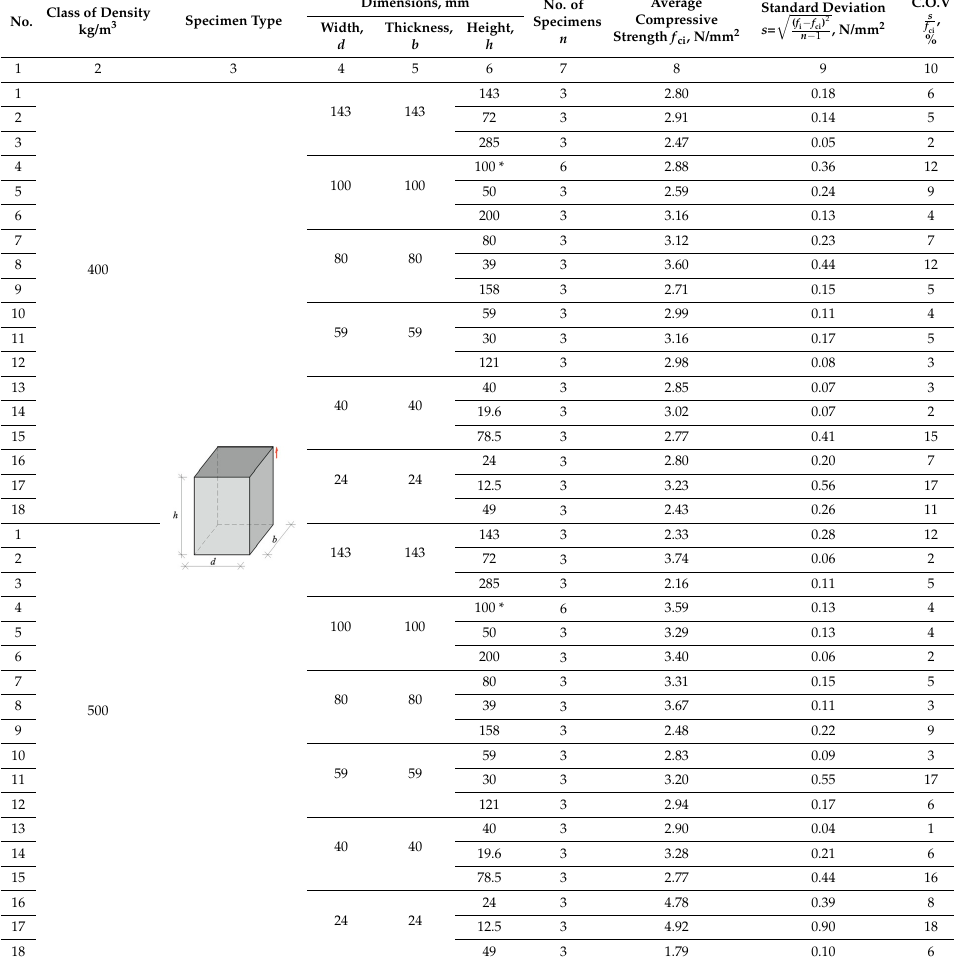
Table 2. Results from compressive tests performed on cuboid specimens.